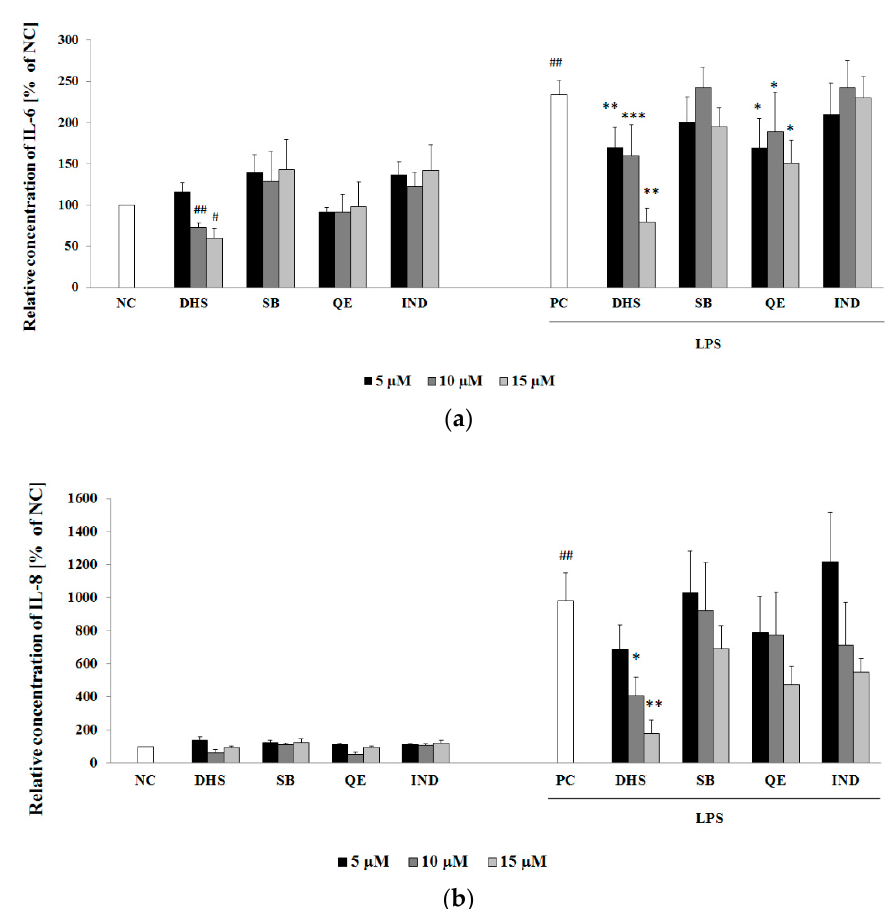
Figure 2. Cytokine IL-6 ( a ) and chemokine IL-8 ( b ) secretion into the medium were determined by ELISA assay, after 24 h treatment with 5, 10 and 15 μ M QE, SB, DHS or IND with or without previous 6 h of LPS challenging. Data are presented as mean percentage relative to NC ± SEM ( n = 3), significantly different from NC ( # p < 0.05; ## p < 0.01) or PC (* p < 0.05; ** p < 0.01; *** p < 0.001). NC: negative control (0.1% vehicle DMSO in serum-free culture medium), PC: positive control (6 h of LPS stimulation followed by 24 h incubation with 0.1% vehicle DMSO in serum-free culture medium).